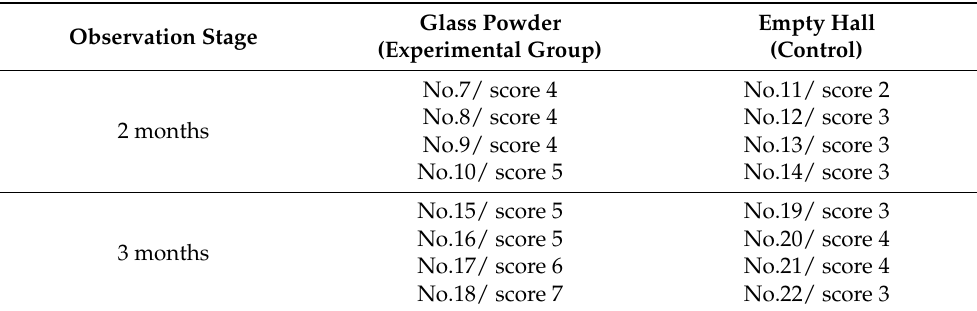
Table 3. Bone formation score for experimental and control groups after 2 and 3 months of implanta- tion according to histological scoring